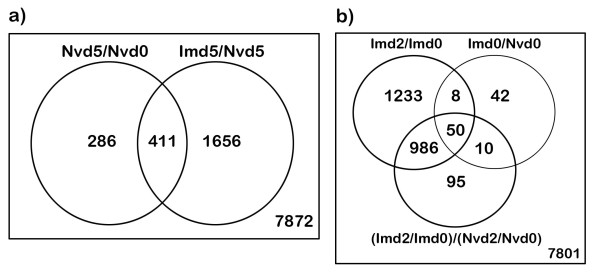
Venn diagrams to illustrate total numbers of genes whose expression levels were significantly altered (FDR ≤ 0.05) detected in each hybridisation experiment; 1a) Expt.1; day 5 post-challenge 1b) Expt. 2; day 2 post-challenge. Nv = "naïve" yearlings, worm naïve prior to challenge; Im = "immune" yearlings, previously infected by trickle infection prior to challenge; d0, d2, d5 = days post-challenge; (details in Table 1). The figures in the circled regions correspond to the number of genes with significantly altered (FDR ≤ 0.05) expression levels in each comparison (details given in Table 2) while the figures in the overlapping regions correspond to the number of genes whose expression levels were significantly altered (FDR ≤ 0.05) in two or more comparisons; eg. 8 genes showed significantly altered expression levels in both the Imd2/Imd0 and Imd0/Nvd0 comparisons. The figures outside the circled regions correspond to the numbers of genes on the array with no significant change in expression level in any of the comparisons.